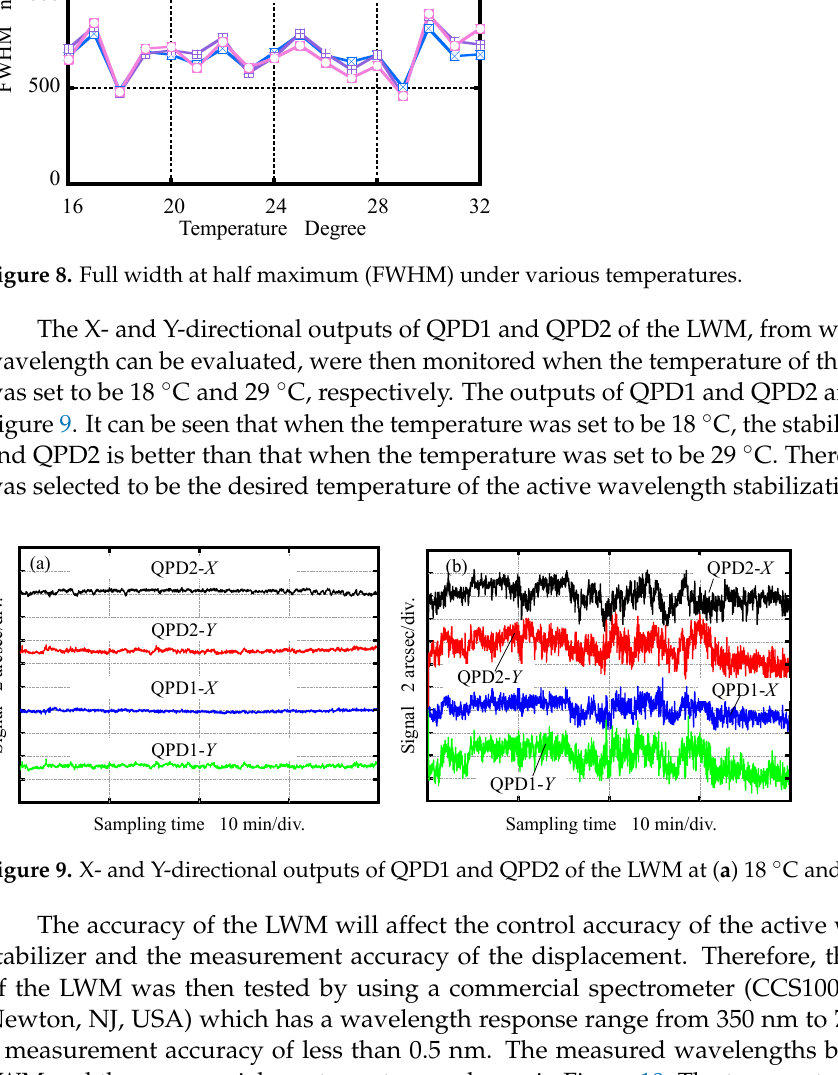
Figure 9. X- and Y-directional outputs of QPD1 and QPD2 of the LWM at ( a ) 18 °C and ( b ) 29 °C.